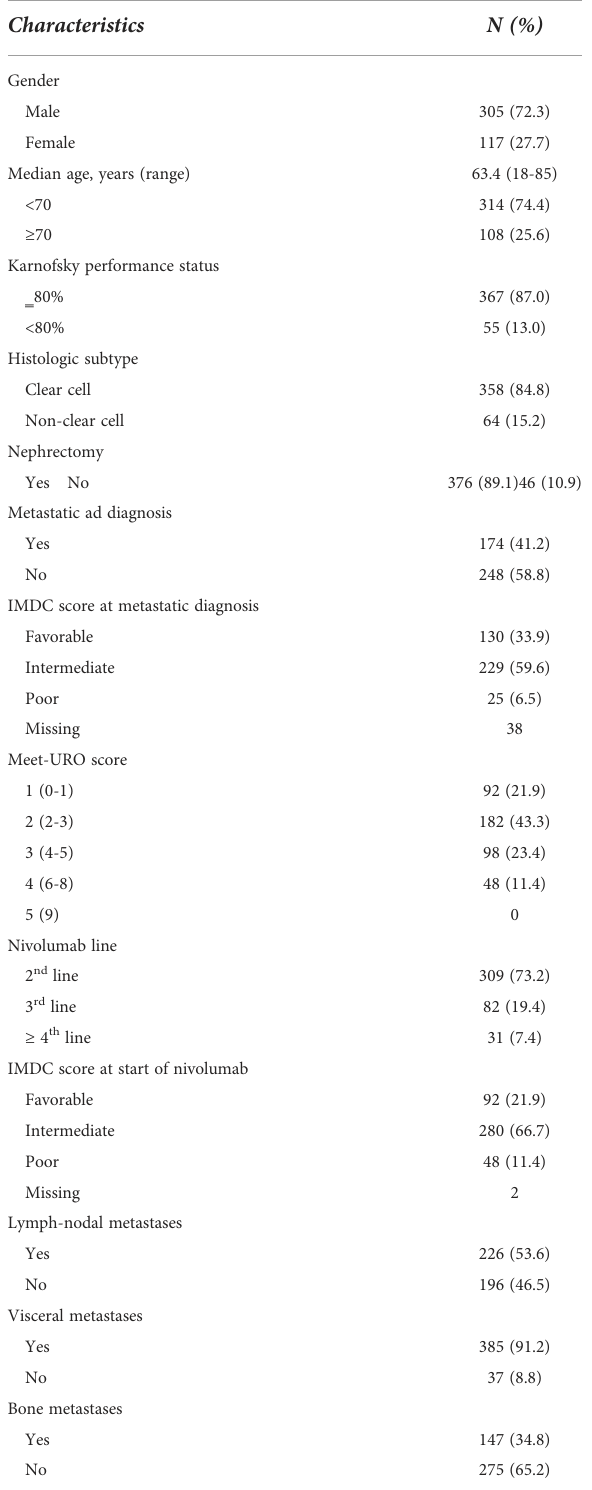
TABLE 1 Patients ’